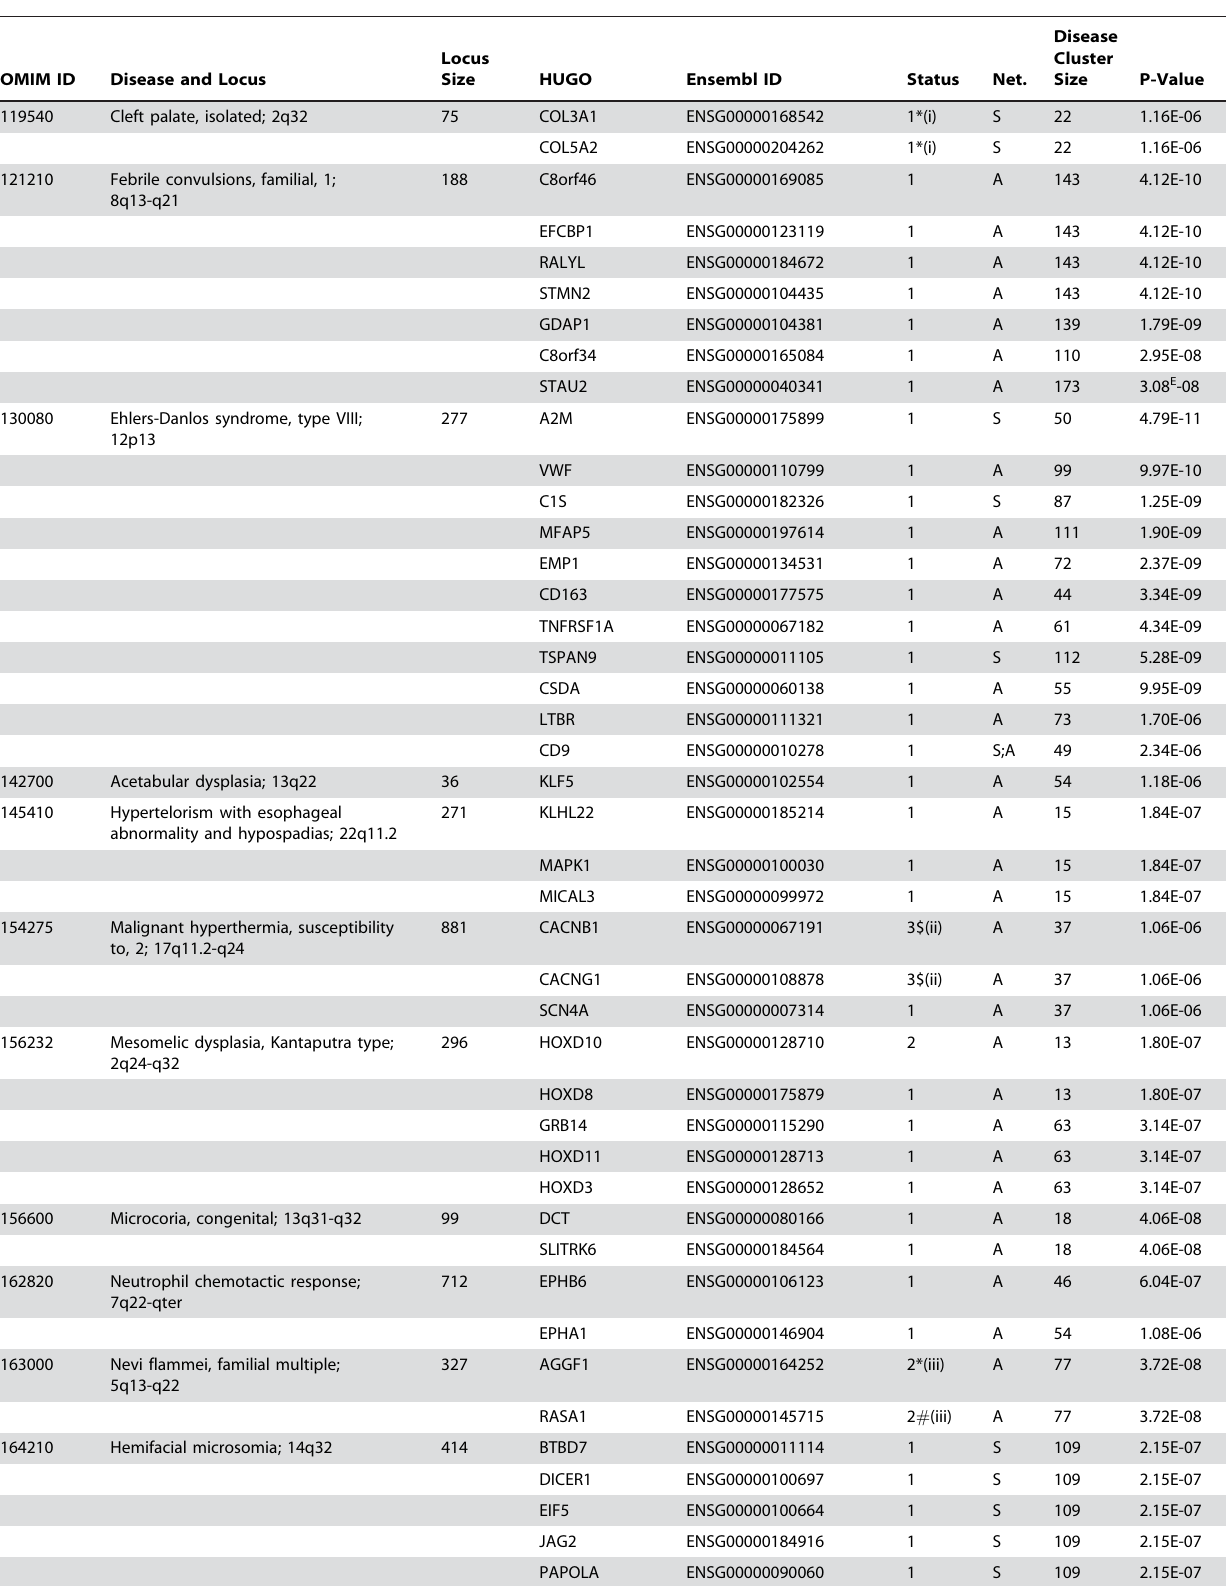
Table 2. List of the candidate genes found for 81 OMIM loci with unknown molecular basis.